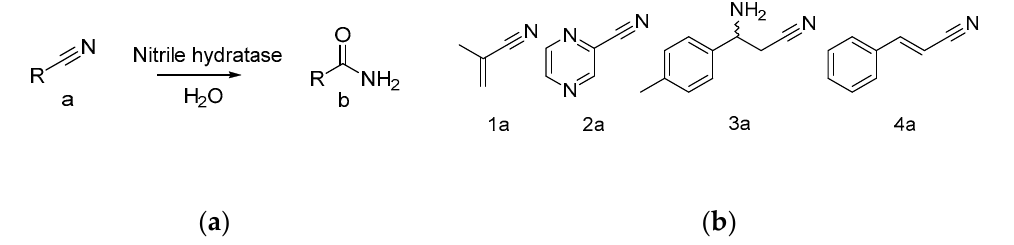
Figure 1. ( a ) Reaction scheme; ( b ) substrates investigated in this study.